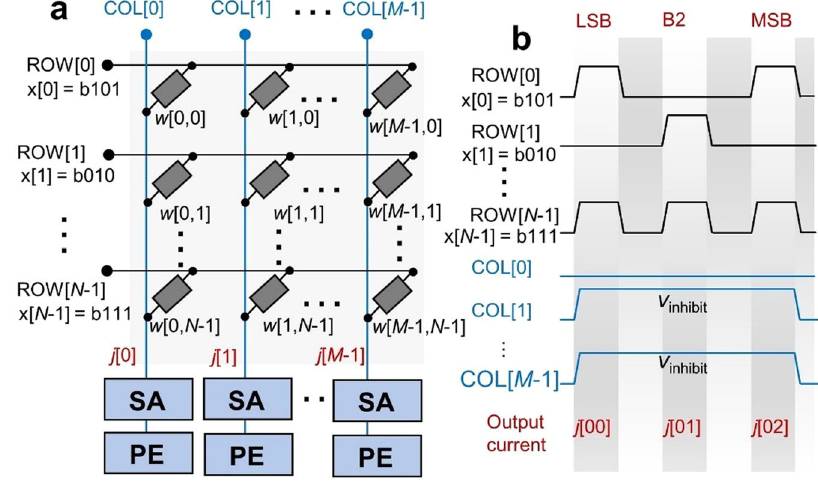
Fig. 9 Acceleration of multibit vector-matrix multiplication. a Con fi guration of a mapped weight matrix w ( M × N ) and multibit vector x (here, 3-bit). Elements x[ i ] are time-multiplexed, so that the multiplication delay is proportional to the bit-width of elements x[ i ]. b Timing diagrams of the signals to calculate w[:, i ]·x for a given i with multibit elements including x[0] ( = b101), x[1] ( = b010), and x[29] ( = b111). The resulting currents in the three time divisions ( j [00], j [01], and j [02]) are fi rst quantized by the SAs and subsequently multiplied by 1, 2 1 , and 2 2 , respectively, and summed in the processing elements